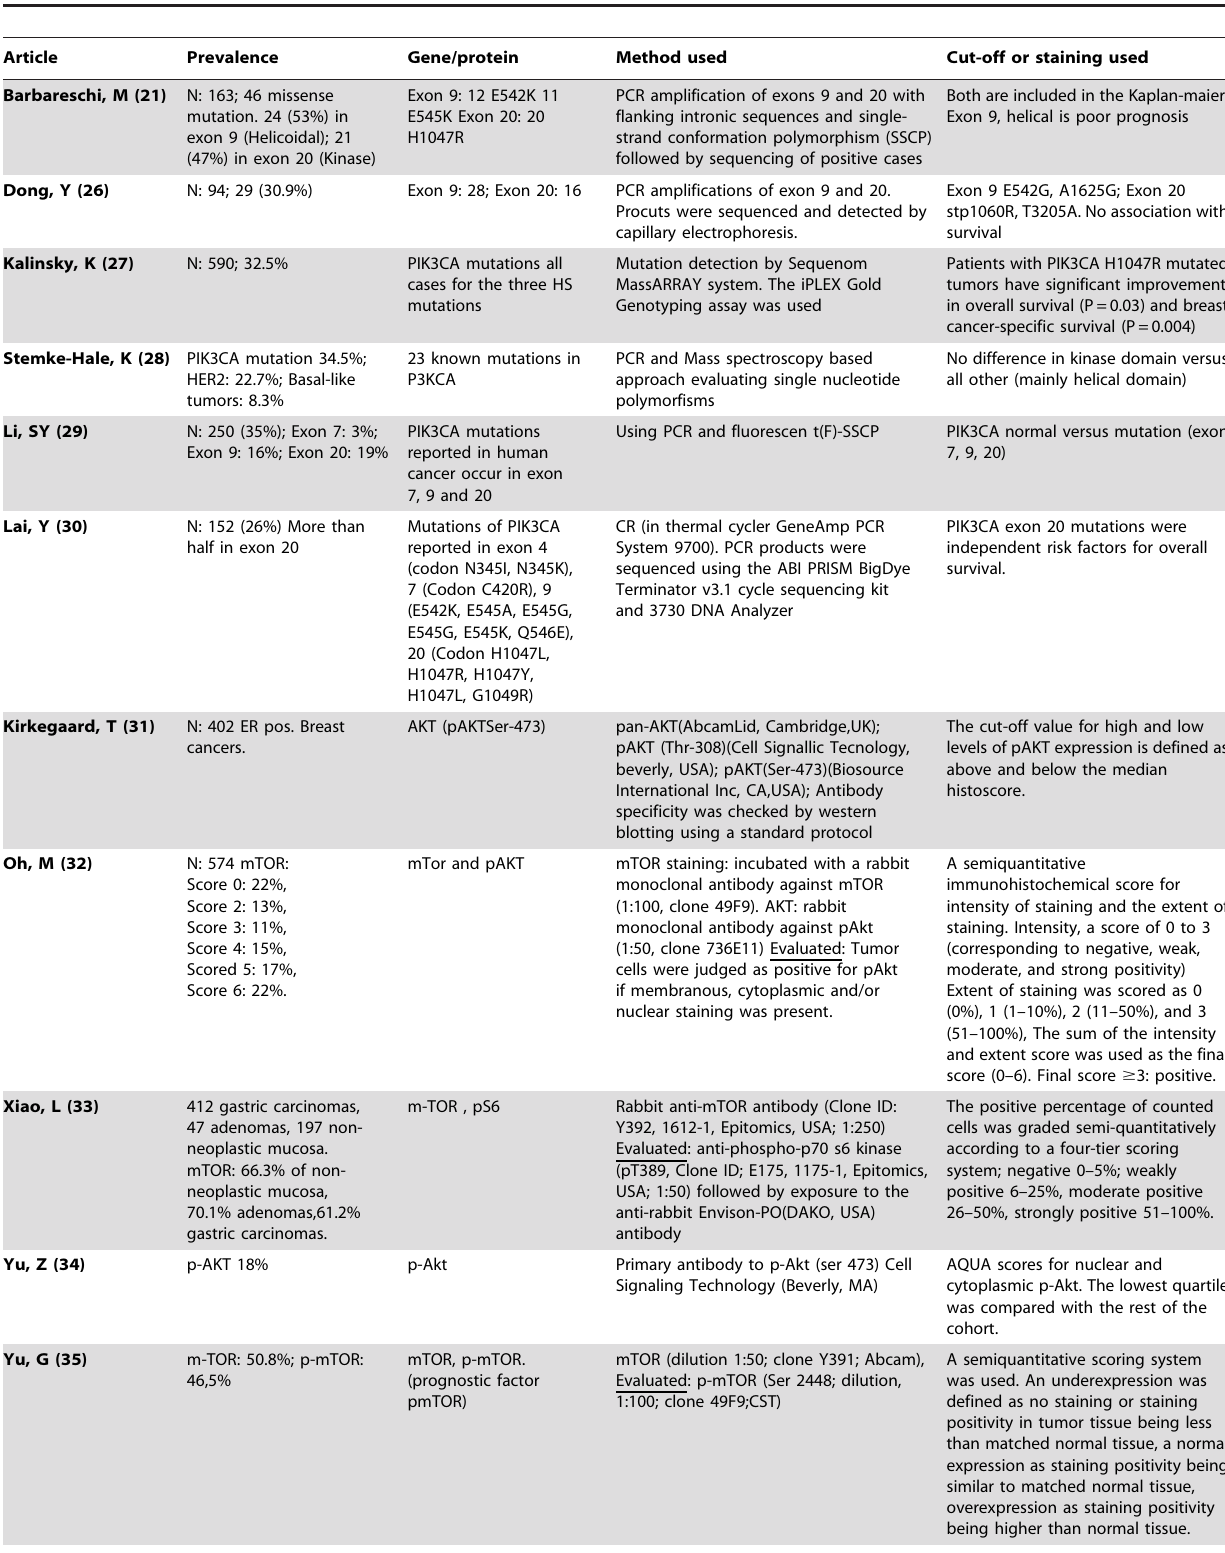
Table 2. Prevalence and analyses of the molecular alterations of the PI3K/mTOR/AKT pathway.